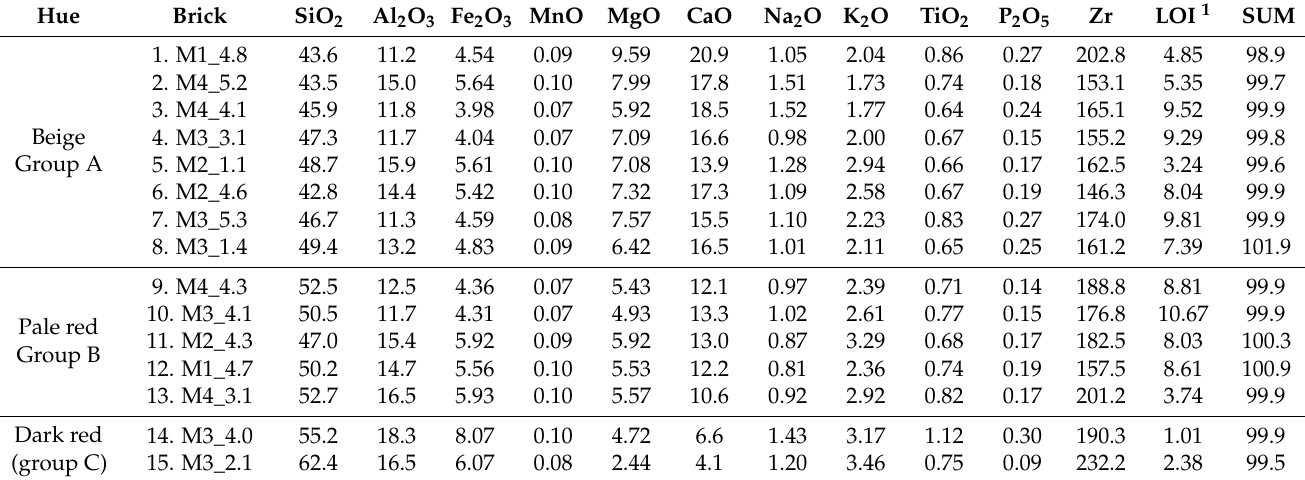
Table 2. Chemical analysis of the major and minor oxides (in wt %) and zircon trace element (in ppm) of the ceramic bodies determined by XRF. Hue SUM